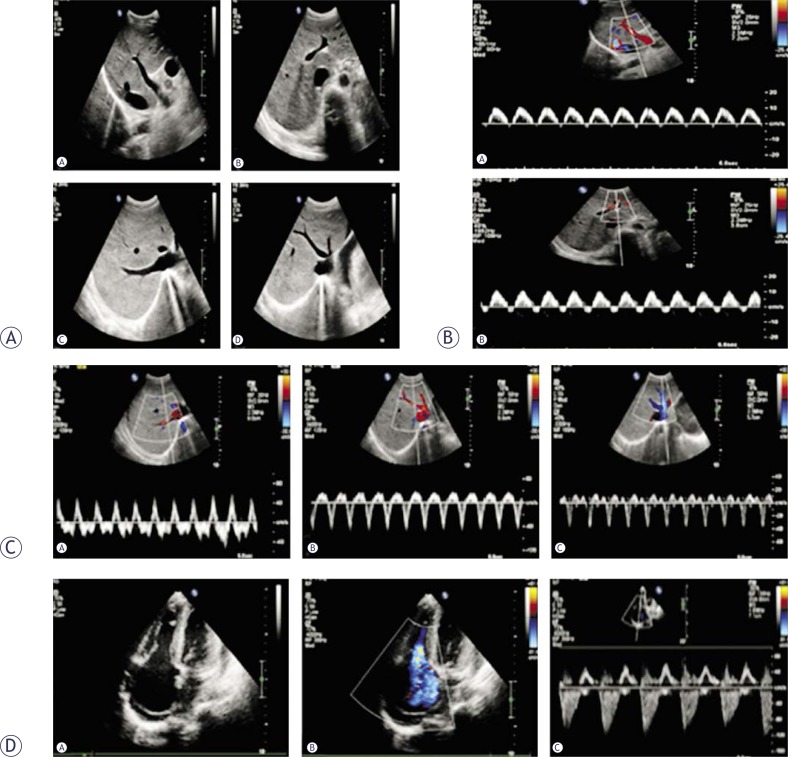
CTS with severe tricuspid regurgitation. (A) Normal US scans demonstrate normal internal diameters of the portal and hepatic veins (a: right branch, b: left branch c: right hepatic vein, d: middle and left hepatic vein). (B) The waveform of velocity tracing in the intrahepatic branch of the portal vein shows a typical hump-like shape with a transitory hepatofugal tracing (a: right branch, b: left branch). (C) PW displays an increase of retrograde phase of hepatic venous flow with increased velocities in the two phases (a: right hepatic vein, b: middle hepatic vein, c: left hepatic vein). (D) Echocardiography shows an enlarged right atrium with severe tricuspid regurgitation (a: Normal ultrasound scans, b: CDFI, c: PW).